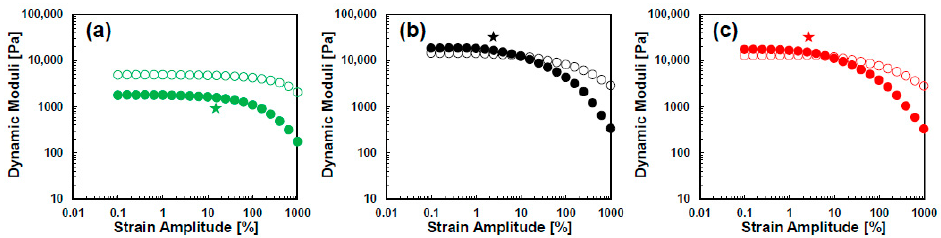
Figure 8. Oscillatory amplitude sweep response of N-MWNTs/PVDF nanocomposites containing 3.0 wt.% of carbon nanotubes synthesized on different catalyst concentrations for strain amplitudes of γ 0 = 0.1–1000% at an angular frequency of ω = 1 rad/s using parallel-plate geometry at a gap-size of 0.3 mm at 210 ˚ C. Open symbols represent loss modulus ( G ′′ ) and solid symbols represent storage modulus ( G ′ ). ( a ) PVDF/N-MWNTs synthesized with 10 wt.% Fe, ( b ) PVDF/N-MWNTs synthesized with 20 wt.% Fe, and ( c ) PVDF/N-MWNTs synthesized with 40 wt.% Fe. The star symbols show the critical strain amplitude (linear to nonlinear transition).